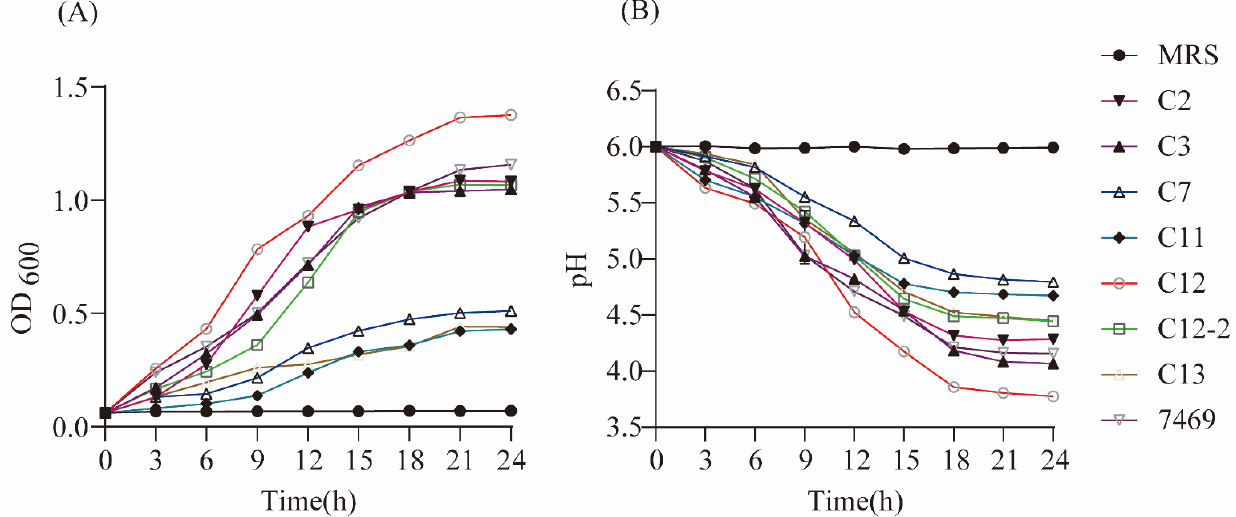
Figure 1. Growth and acid-producing ability of selected strains. ( A ) Growth curve of selected strains; ( B ) acid-producing curve of selected strains.